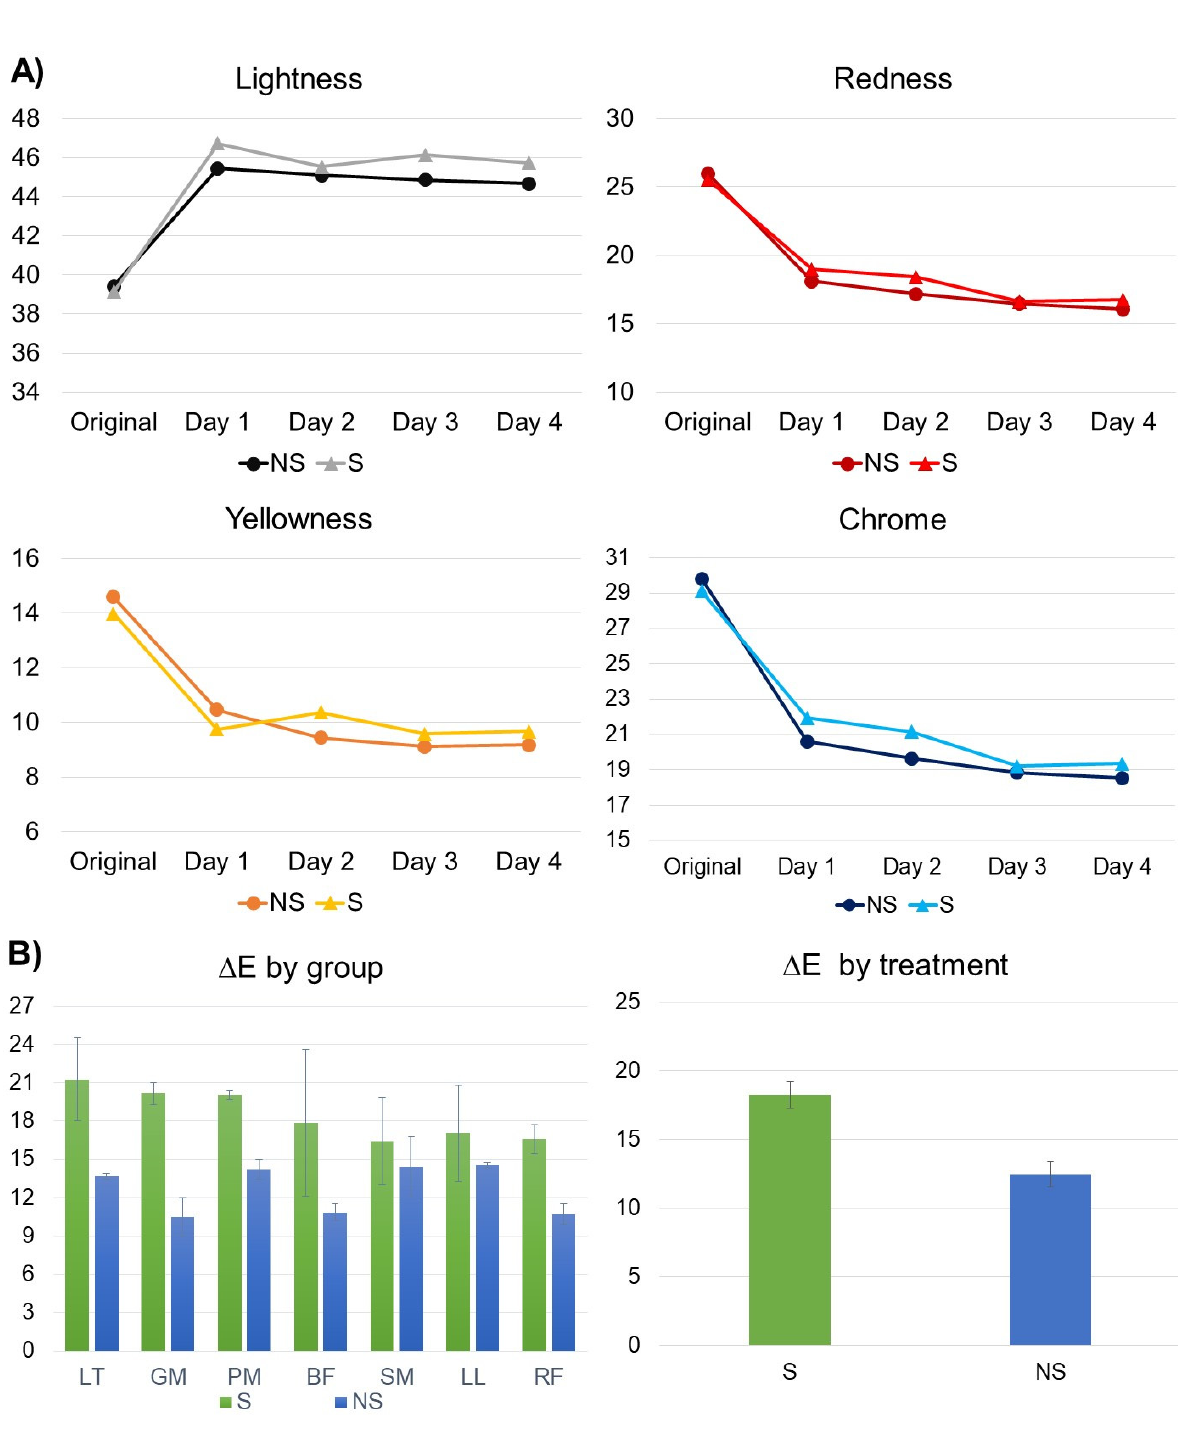
Figure 1. Colour change of 23-day-aged beef; ( A ) During simulated retail display (75% O 2 : 25% CO 2 , 3 ◦ C) for 5 d; and ( B ) Total colour differences ( ∆ E) at the end of the retail display. NS = Not ultrasonicated. S = Ultrasonicated (US, 28 W/cm 2 ). BF = Biceps femoris . GM = Gluteus medius . LL = Longissimus lumborum . LT = Longissimus thoracis . PM = Psoas major . RF = Rectus femoris . SM = Semitendinosus . Significant differences ( p < 0.05) were found among muscles (Figure 2A). Semitendinosus was tougher than the rest of the analysed muscles, while Psoas major tended to be the tender ( p = 0.11) muscle, which agrees with previous comparisons done for these muscles [49]. Positive effects of HIU on fresh beef tenderness have been documented [26,27]. Nevertheless, shear force characteris- tics of aged beef were not affected ( p > 0.05) by HIU application in the present study. No added effect of HIU was observed on tenderness in addition to the tenderness provided by the ageing process (Figure 2). Beef ageing has been widely recognized as a process to preserve and improve the tenderness of meat. The increase in meat tenderization by dry ageing results from a natural proteolytic enzyme post-mortem process by calpains and other proteases. These enzymes carry on an extensive prote- olysis degrading myofibrillar proteins and cytoskeletal anchorage complexes in muscle fibres